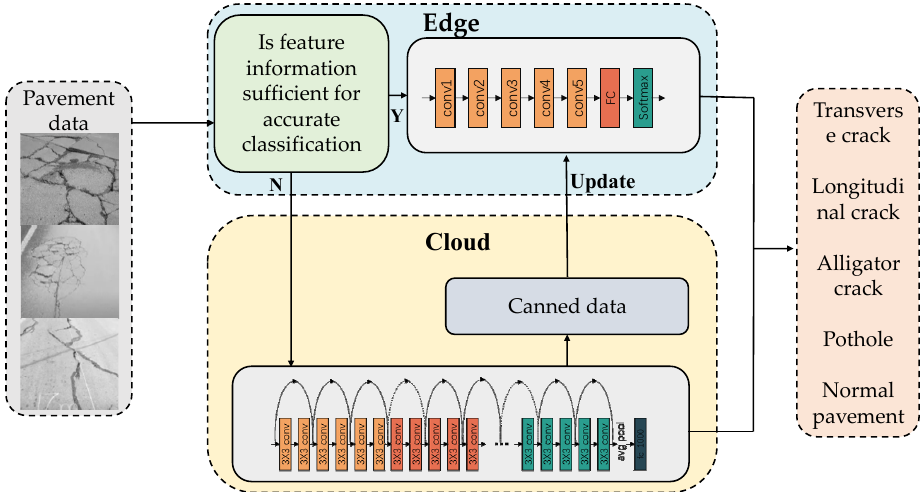
Figure 2. Method flow chart.